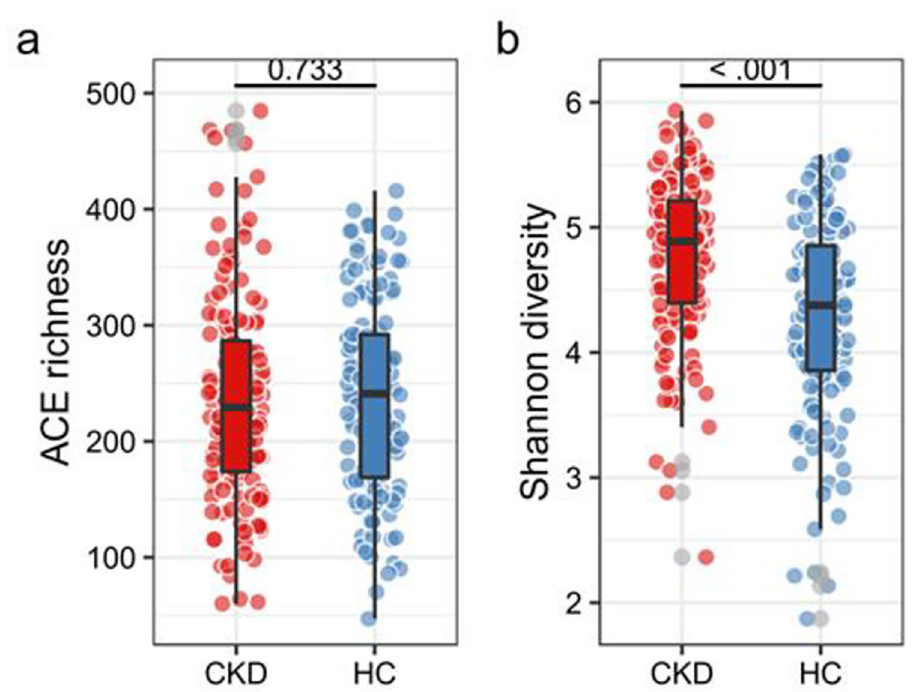
Fig 2. The Alpha diversity of gut microbiota in different groups. (a) ACE index reflected the richness of two groups, it showed that the influence of different groups on microorganisms richness might be limited (P = 0.733), (b) The results showed that Shannon index between two groups was statistically different (P < 0.001), indicating that the evenness of the gut microbiota was affected by CKD.